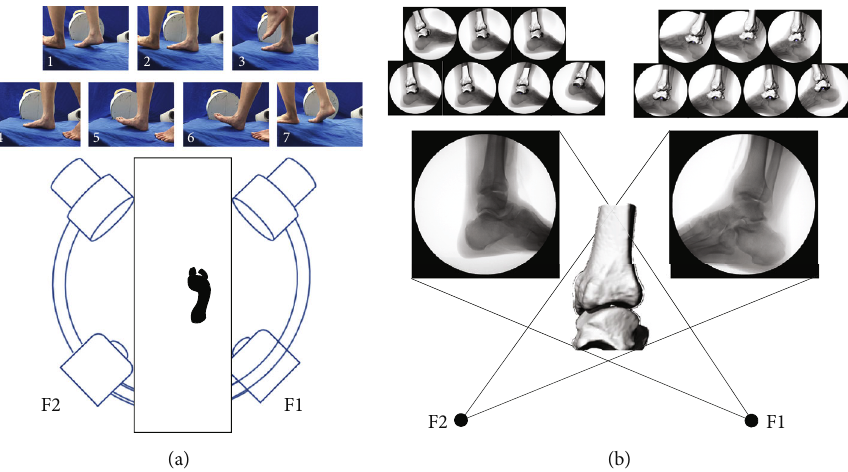
Figure 1: (a) Seven key poses of the right foot selected for analysis and illustration of the dual fl uoroscopic system (two approximately orthogonal fl uoroscopies F1 and F2). (b) Model-image registration method to reproduce the in vivo position of the bones of the hindfoot.